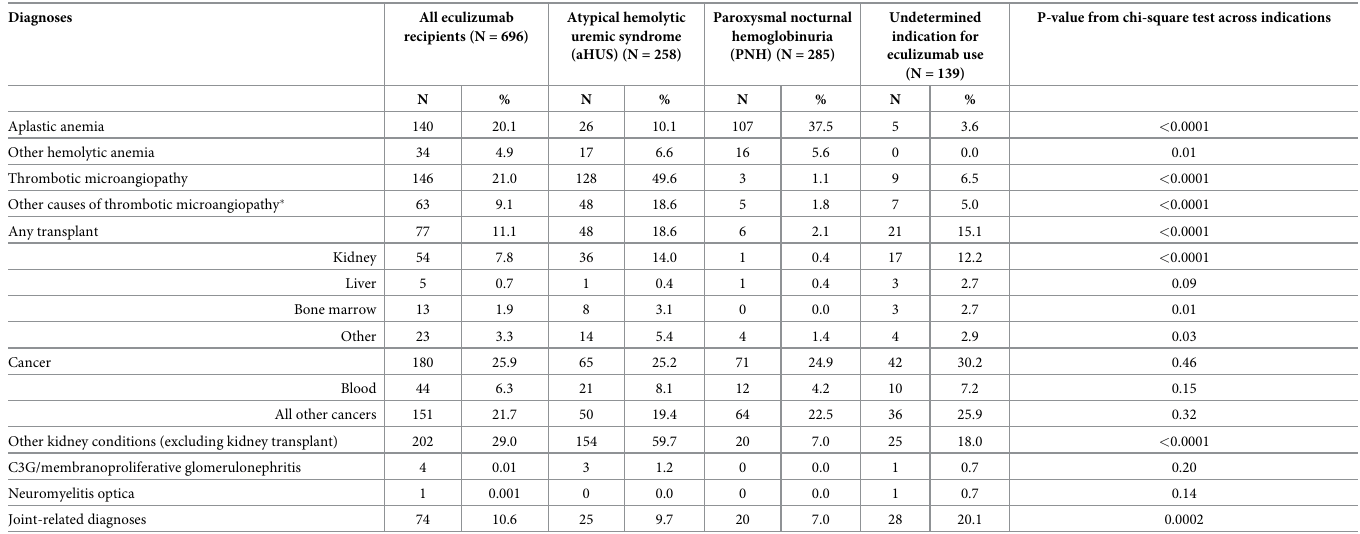
Table 2. Underlying conditions within the defined six-week window of 30 days before to 14 days after first documented eculizumab treatment among eculizumab recipients in the IBM Marketscan Commercial Database, 2007–2017. Diagnoses Alleculizumab Atypicalhemolytic recipients(N=696) uremicsyndrome